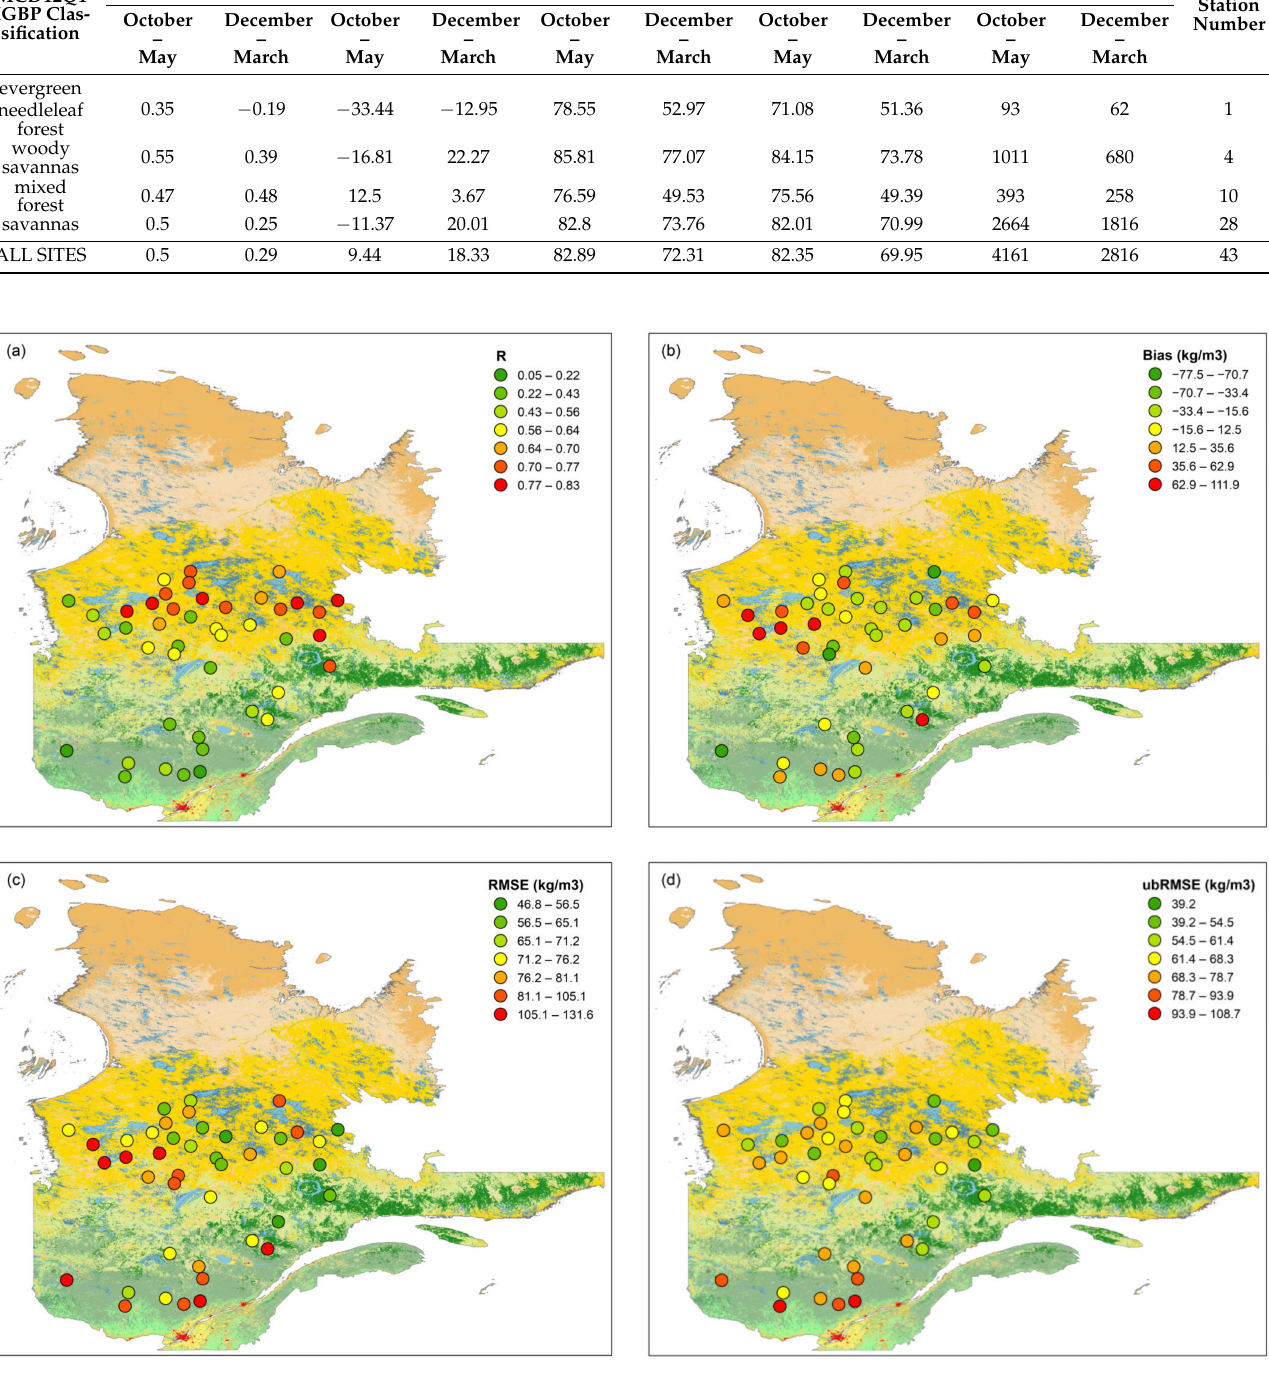
Figure 8. Distribution of Pearson correlation coefficient (R) ( a ), mean bias (Bias) ( b ), root-mean- squared error (RMSE) ( c ), and unbiased (ubRMSE) ( d ) of retrieved snow density at stations on map. The background is the MCD12Q1 IGBP